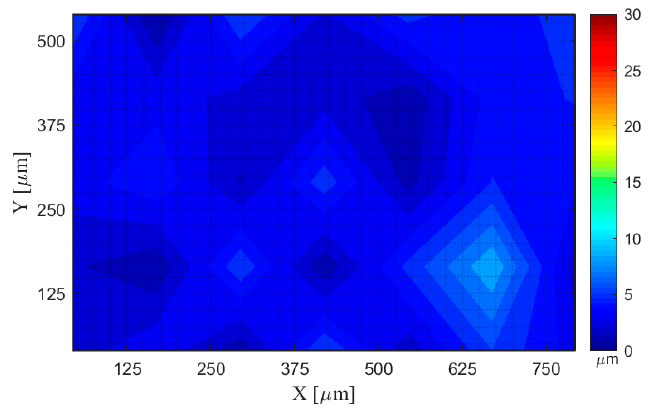
Figure 13. Contour of the Euclidean residuals between each certified and corrected points.